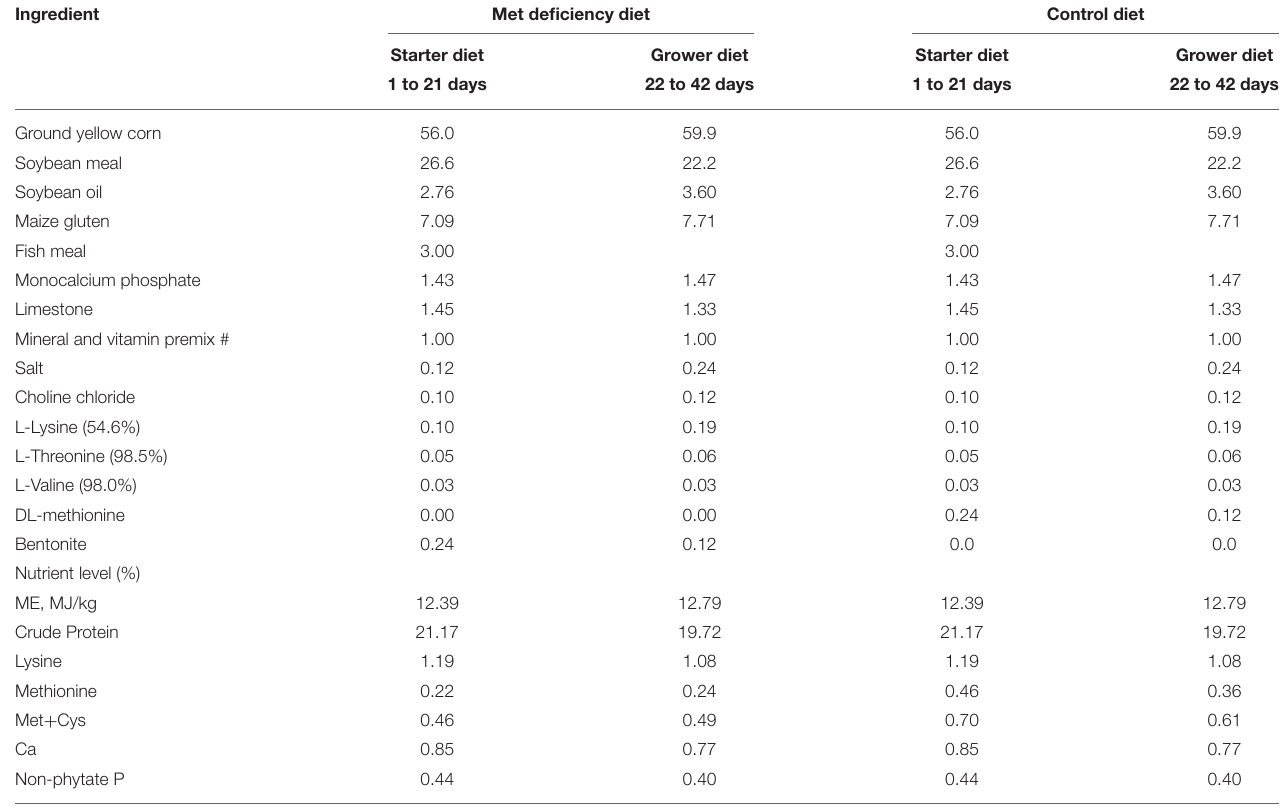
TABLE 1 | Diet components of the control and Met deficiency group (%). Ingredient Met deficiency diet Control diet Starter diet Grower diet